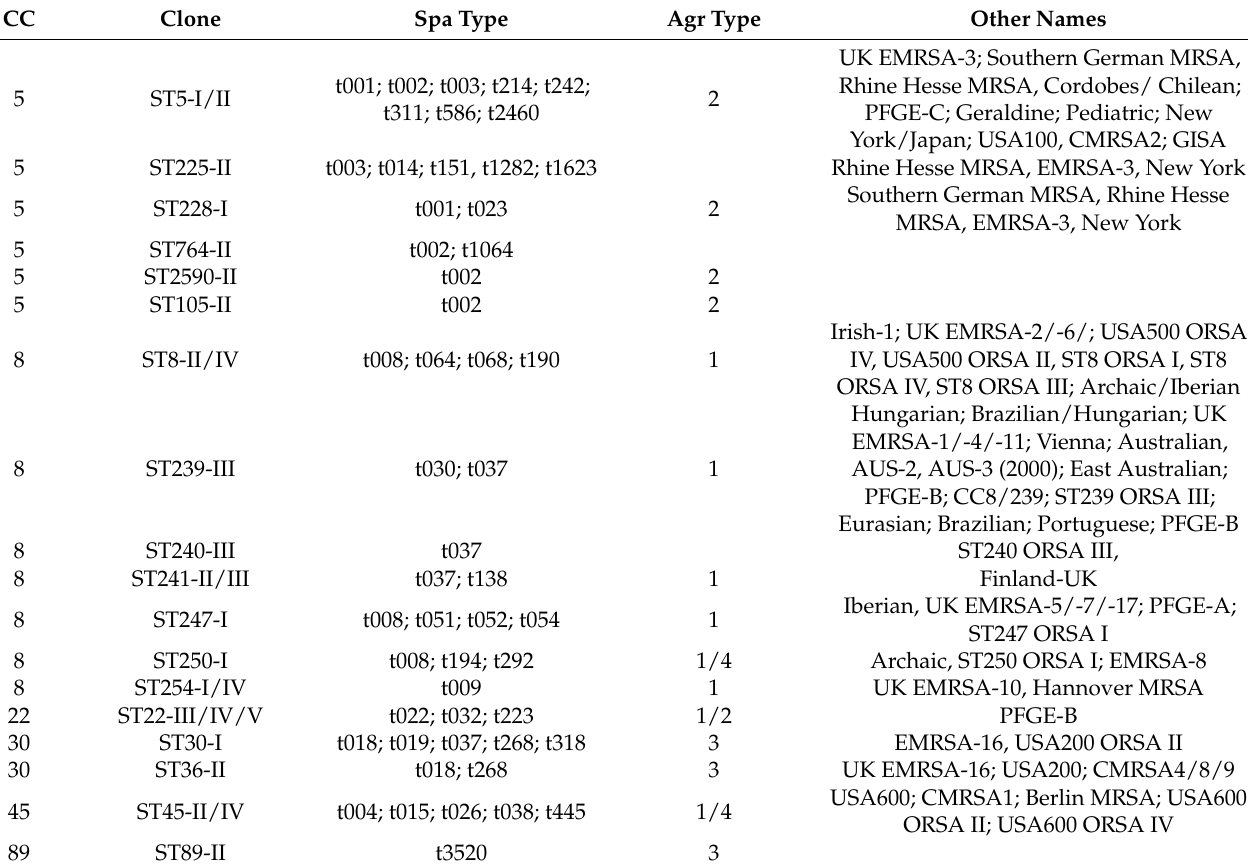
Abbreviations: as in the Table